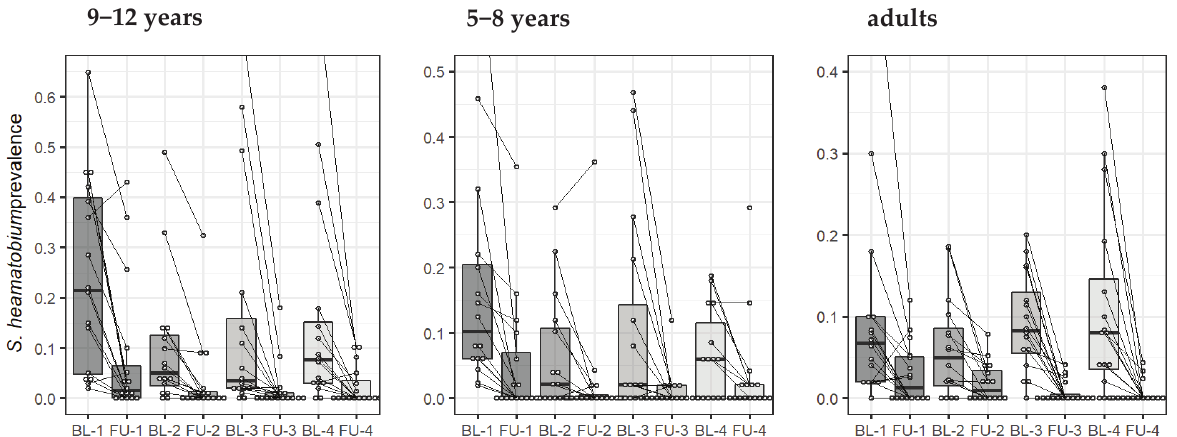
Figure 4. Change in S. haematobium prevalence in 64 villages (16 by arm) from baseline (BL) to the first year follow-up (FU), stratified by age group and by study arm (arms 1, 2, 3, and 4). Each line indicates the evolution of one village from baseline to year one, and the boxplots show the distribution by study arm.